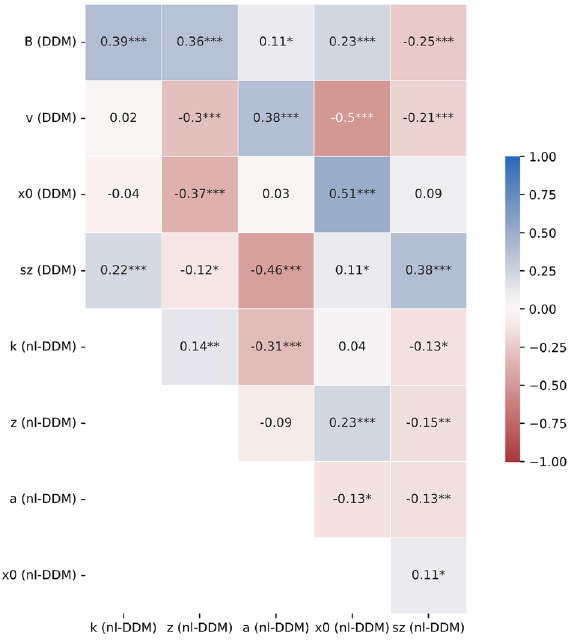
Figure 4. Correlation matrix of all parameters, computed from the parameters fitted over data simulated from DDM parameters. Pearson correlation coefficients were computed over N = 400 observations. This figure was obtained using the matplotlib (3.5.2) 30 -based Python library seaborn (0.11.2) 31 (see https:// matpl otlib. org/